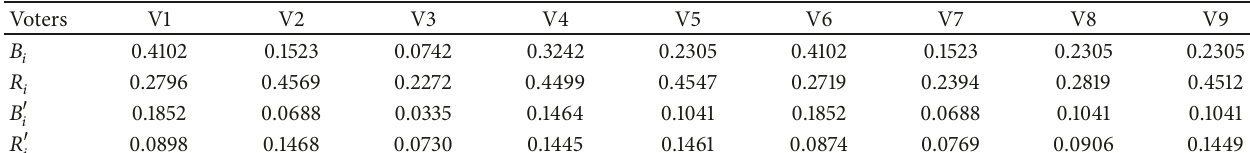
Table 2: Banzhaf indices and integrated power indices for voters.